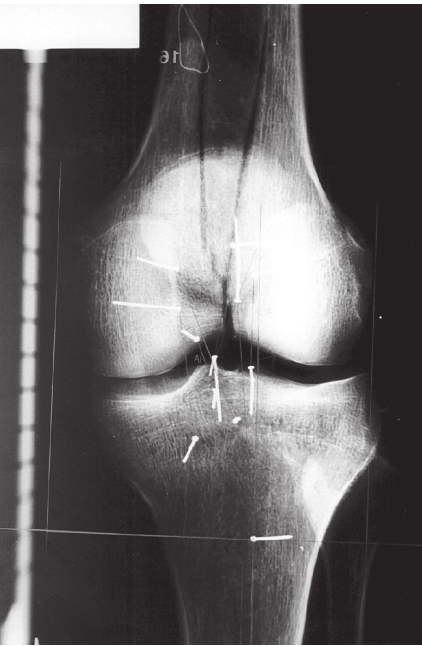
Figure 3 - Radiograph of an anterior-posterior view of the knee in extension 0° (specimen no. 16), where the metallic pins of the femoral and tibial attachment points as well as the metallic pin on the tibial protuberance (anatomical axis) can be